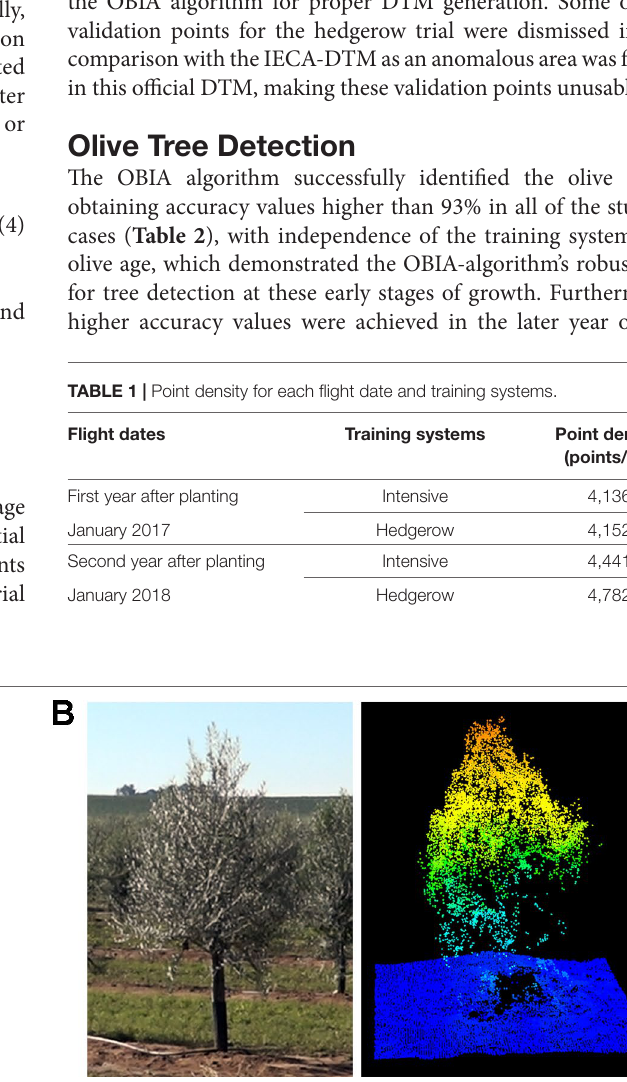
FIgUrE 6 | Field photograph and tree point cloud for an olive tree composing the intensive trial in the consecutive years of data collection: (A) January 2017—15 months after planting; (B) January 2018—27 months after planting.